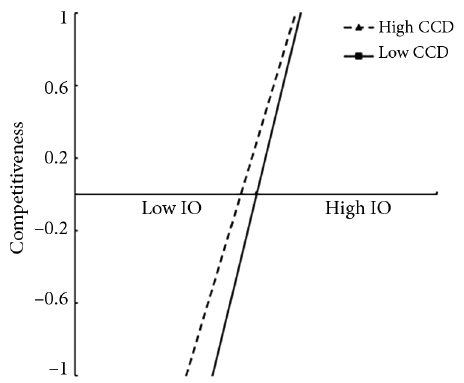
Figure 4. Moderating effect of the coupling degree on the relationship between IO and